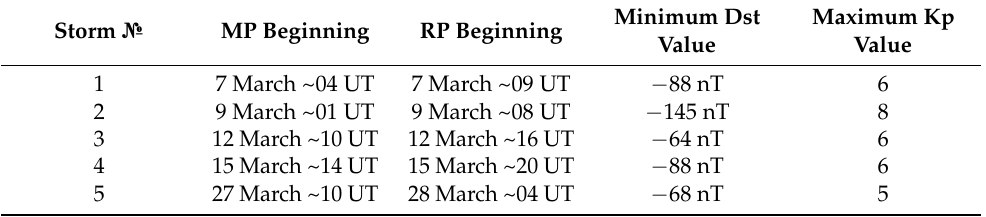
Figure 1. Map of four ionosonde locations. Table 1. Parameters of geomagnetic storms during March 2012. MP, main phase; RP, recovery phase.